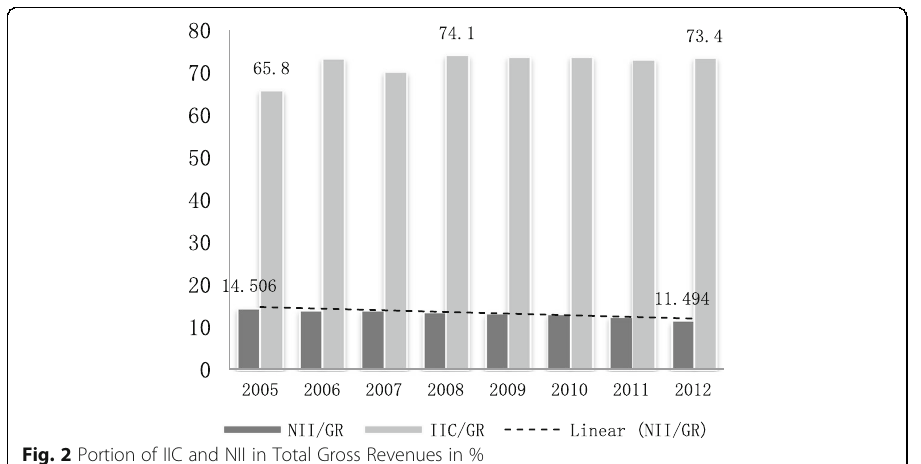
Fig. 2 Portion of IIC and NII in Total Gross Revenues in